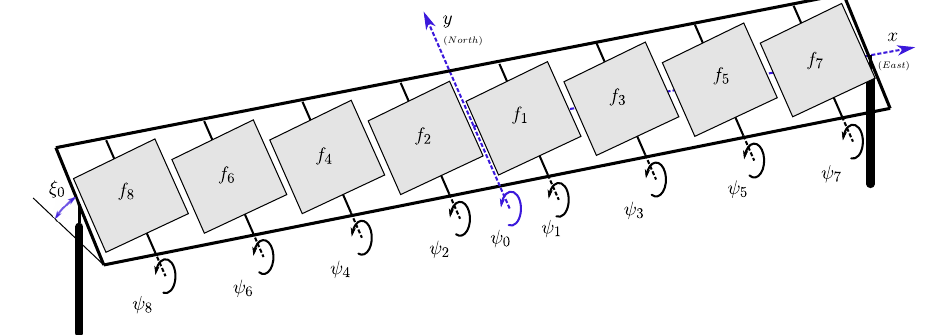
Figure 1. Concept of the elevation–Fresnel mini-heliostat array.